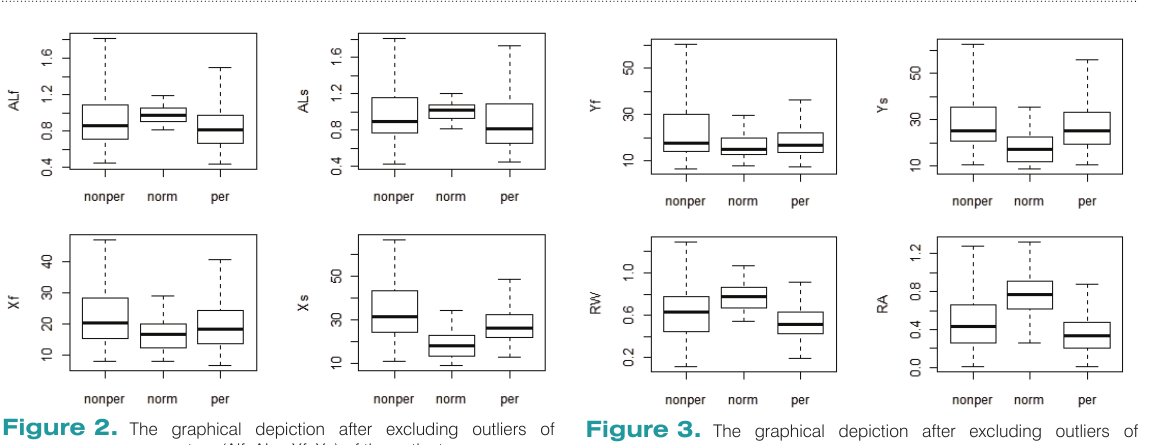
Figure 2. The graphical depiction after excluding outliers of Figure 3. The graphical depiction after excluding outliers of parameters (Alf, ALs, Xf, Xs) of the patient groups. parameters (Yf, Ys, RW, RA) of the patient